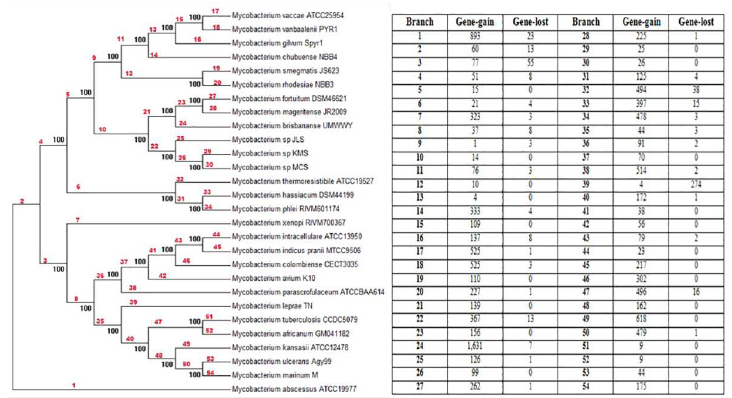
Fig 3. The recombination rate and number of gene gain and lost during the evolution of the Mycobacterium species.